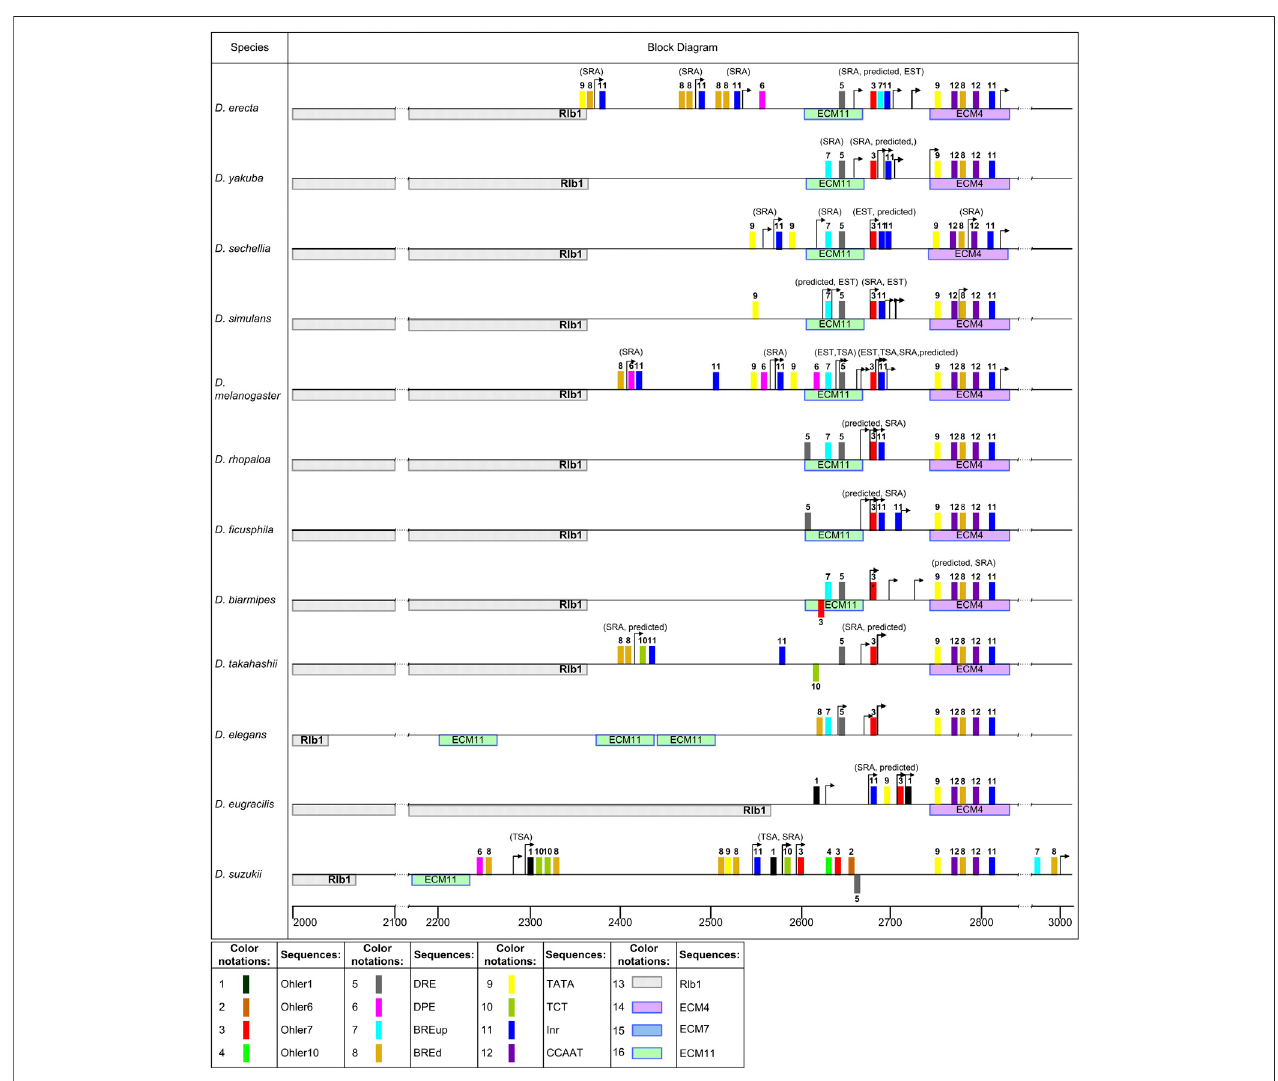
FIGURE7| PatternsofpromoterelementsintheTSSregionsofthe ras85D geneanditsorthologsinthestudied Drosophila species.Distributionoftheelementsin thepromoterregioninthe melanogaster group.Thescalebelowthelineshowsthepositionfromthestartoftheoverallalignment.Coloredrectanglesrepresentpromoter elements. The elements shown under the straight line indicate homology with the minus-strand of DNA. TSS are marked with arrows. The gene located upstream is marked on the left side of the diagrams.